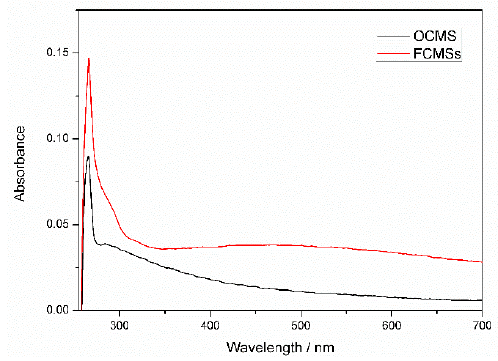
Figure 7. The UV-Vis spectra of FCMSs and OCMSs.